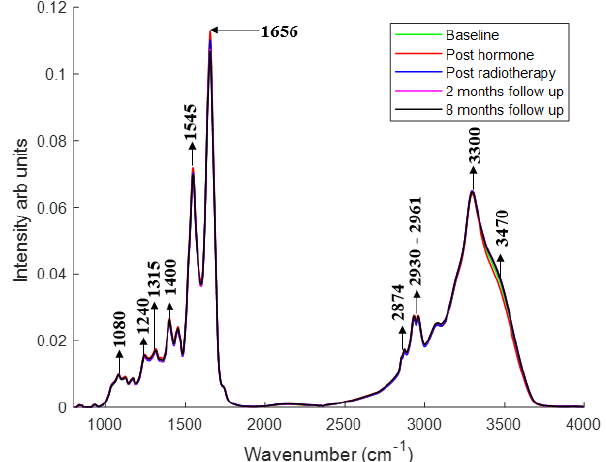
Figure 1. Mean FTIR spectra of plasma from patients at baseline, post hormone treatment, post radiotherapy, two and eight months after radiotherapy. Spectra were baseline corrected and vector normalized. Major bands are highlighted.